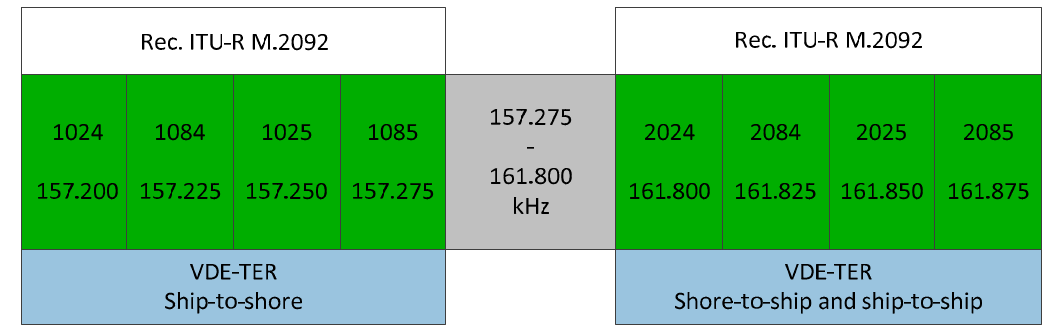
Figure 1. VHF Data Exchange (VDE) physical channel configuration.